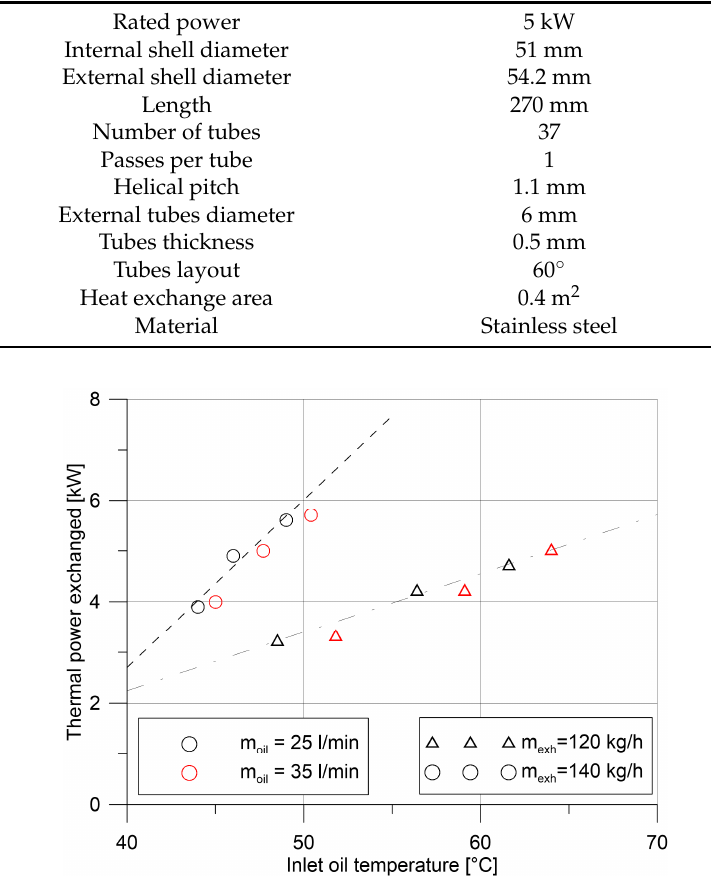
Figure 4. Heat exchanger characterization: thermal power vs. inlet oil temperature. Energies 2018 , 11 , 10